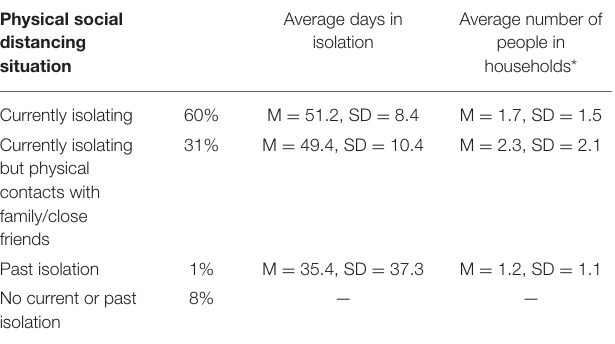
TABLE 4 | Participants’ physical social distancing